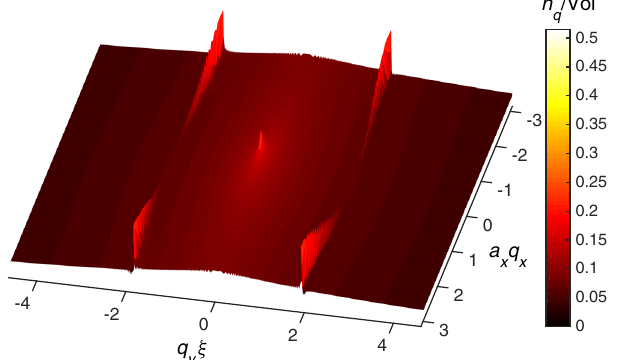
FIG. 1. The quasiparticle momentum distribution n of a 2D q shaken BEC trapped in a one-dimensional lattice (along x ), and allowed to move along a continuous (tube) transverse direction ( y ), develops unique resonance structures in the presence of a periodic drive. Dominating the dynamics in the early stage of evolution, they signal the onset of instabilities and provide a clear experimental signature of the parametric resonance phenomenon explained in this work. The momentum distri- bution is shown after 60 driving periods ( t ¼ 60 T ). Here, the distribution n is divided by the system ’ s volume Vol, ξ q denotes the BEC healing length, and a is the lattice spacing x constant. The precise model and the corresponding parameters are the same as in Fig.